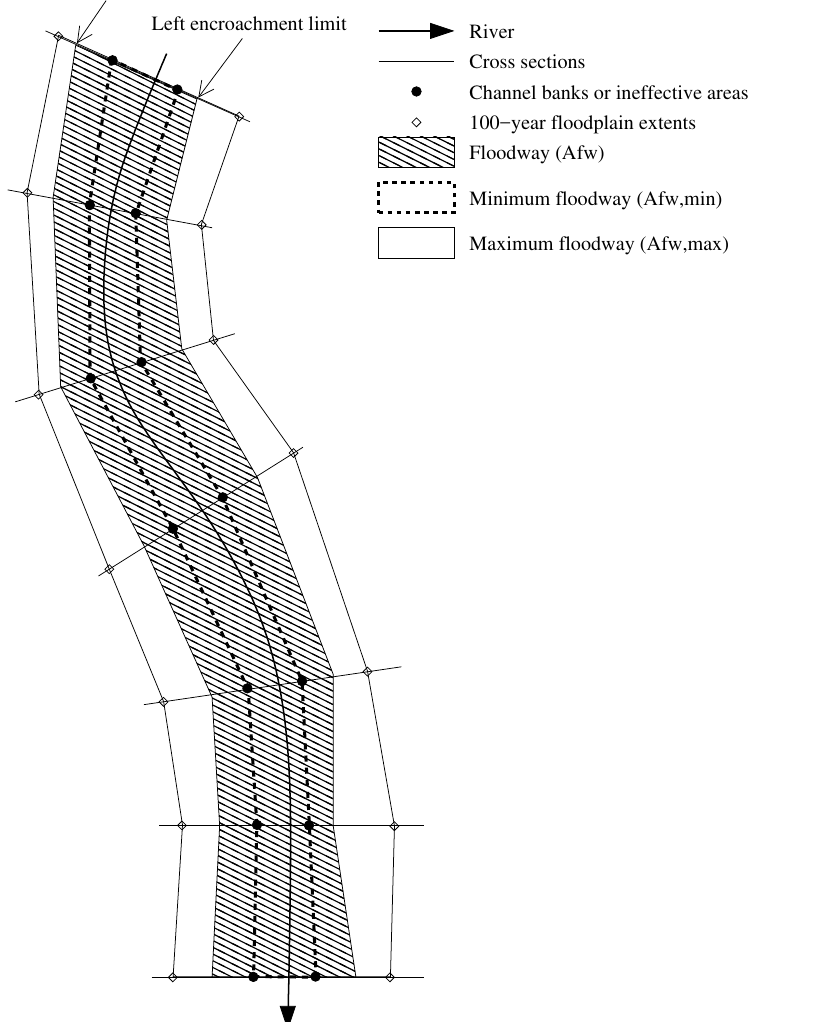
Figure 4. Plan view of a floodway along with a river, cross sections, channel banks, and 100-year floodplain